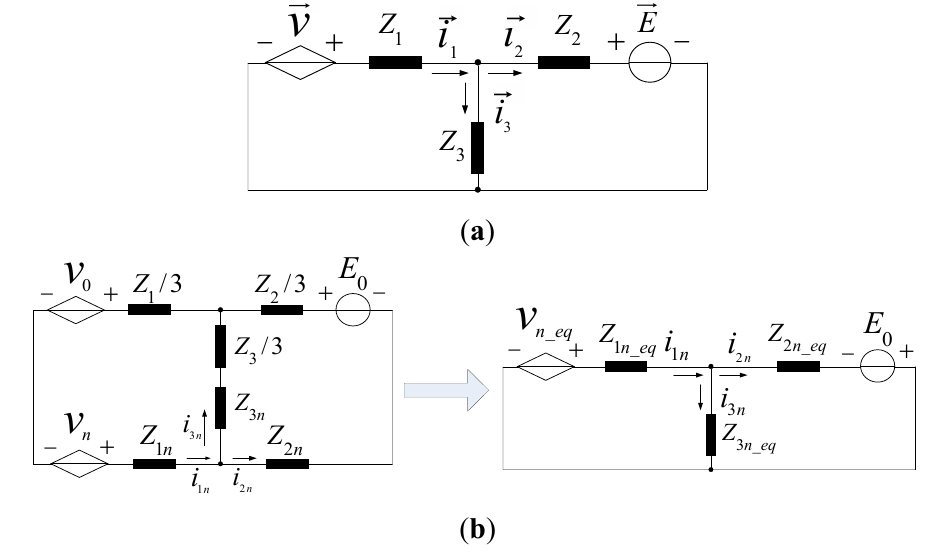
Figure 5. Equivalent circuit in ( a ) the non-zero-sequence and ( b )